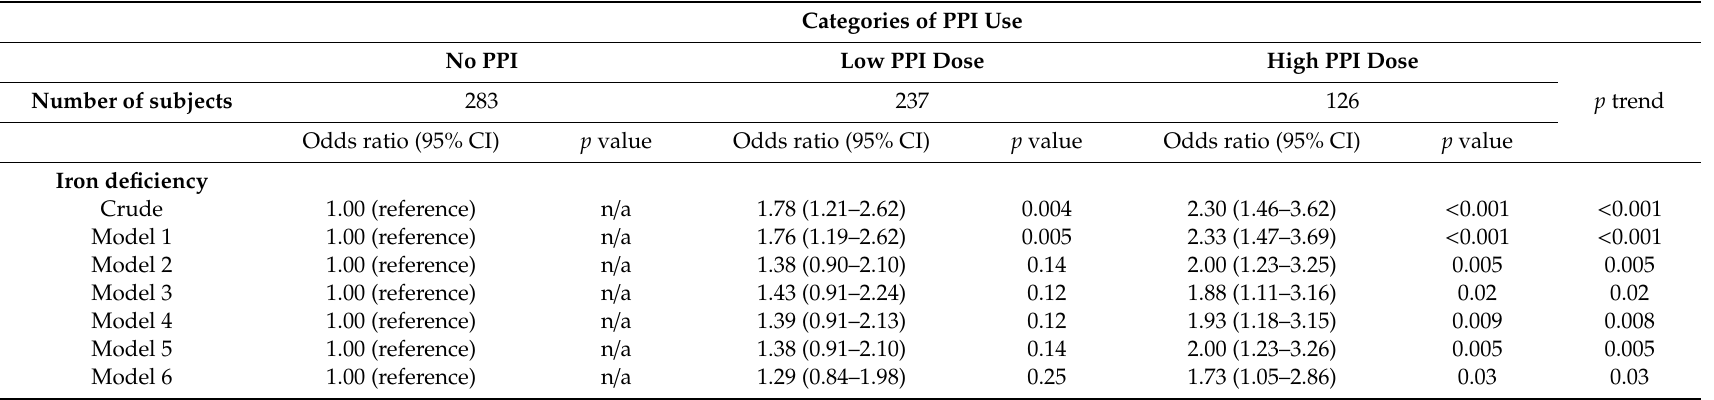
Table 4. Subgroup analyses of the association of PPI use with iron deficiency in 646 stable renal transplant